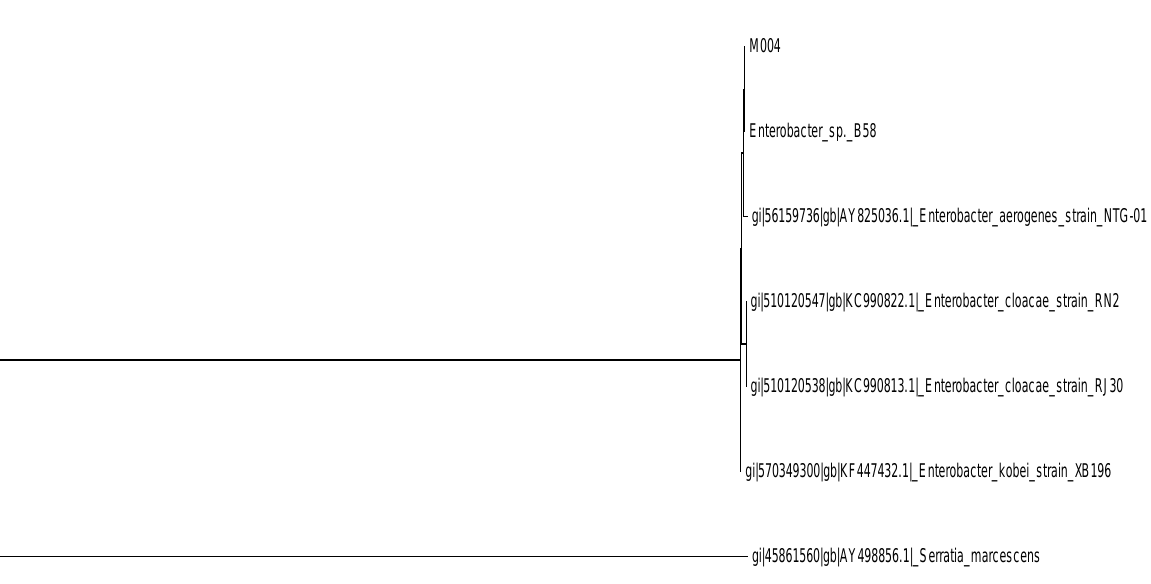
Figure 2. The evolutionary history was inferred by using the Maximum Likelihood method based on the Tamura-Nei